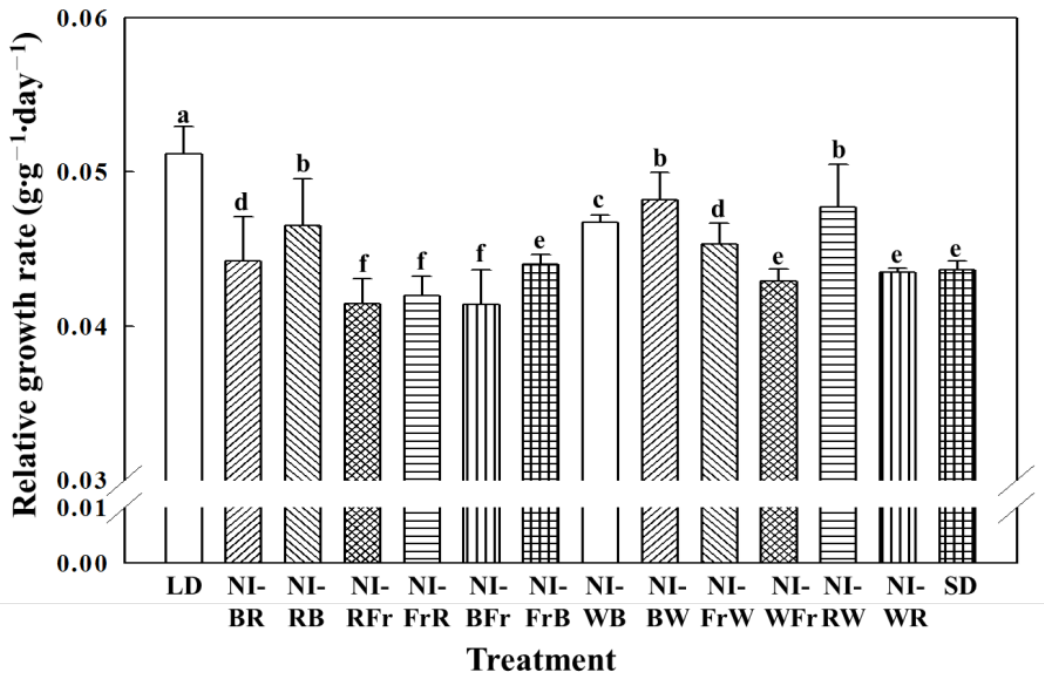
Figure 4. Effects of 10 μmol·m −2 ·s −1 PPFD night-interruption light (NIL) quality shifting on the relative growth rate of geranium ( Pelargonium × hortorum L.H. Bailey ‘Ringo 2000 Violet’) measured 40 days after treatment. Please refer to Figure 1 for detailed NIL qualities. Vertical bars are means ± S.E. (n = 3). Means accompanied by different letters are significantly different ( p < 0.05) according to Duncan’s multiple range test at 5% significance level.